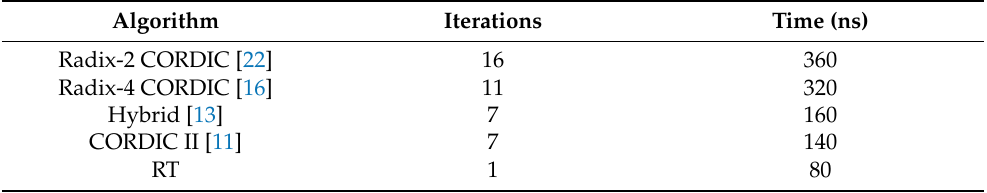
Table 5. Comparison of latency using the related